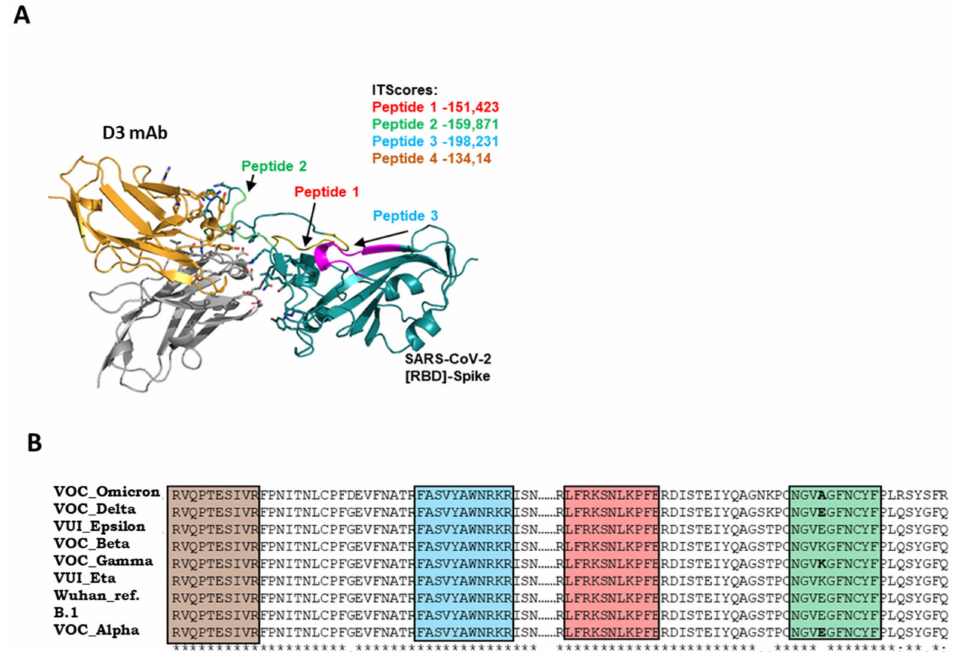
Figure 2. Molecular docking of D3 antibody with Spike protein of SARS-CoV-2. ( A ) The heavy and light chains of the D3 antibody are represented in yellow and gray, respectively. The SARS-CoV-2 Spike protein (RBD region) is presented in cyan. The first 3 peptides, as designed to map the interaction region between the D3 antibody and Spike protein, are also shown in red, green and blue, respectively. The fourth peptide is not shown because it is outside RBD region. The IT scores of the peptides are shown. ( B ) The aminoacidic sequences of the indicated Spike-RBD variants are reported by highlighting in colored squares those referred to the peptide 1 (red), peptide 2 (green), peptide 3 (blue) and peptide 4